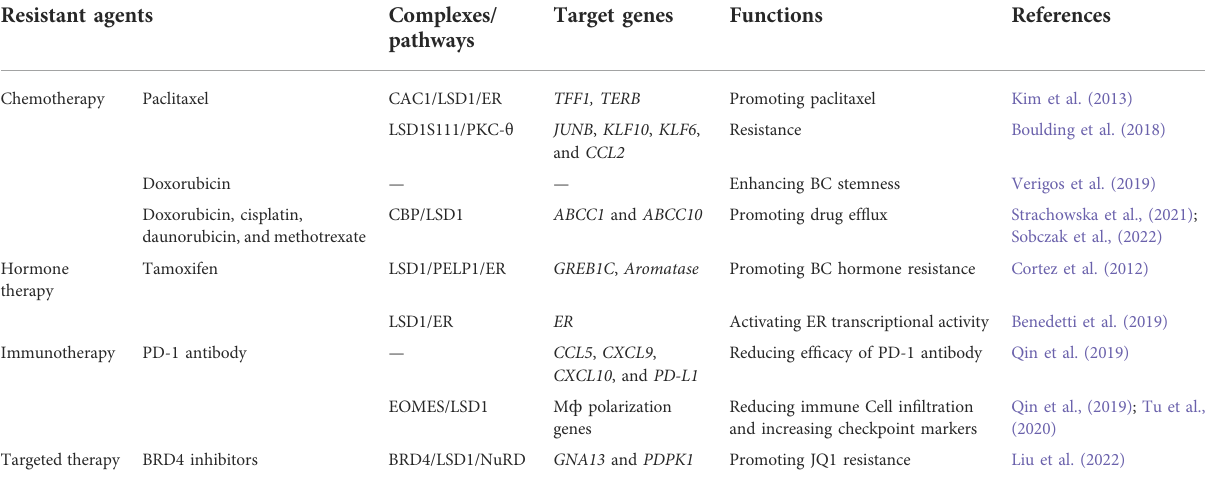
TABLE 3 Roles of LSD1 in drug resistance of